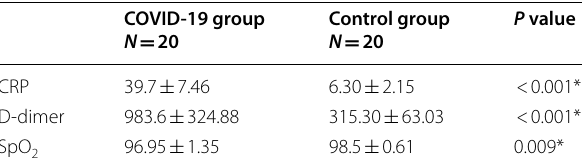
Table 2 Laboratory data and oxygen saturation level of the COVID-19 patients with peripheral neuropathy and control